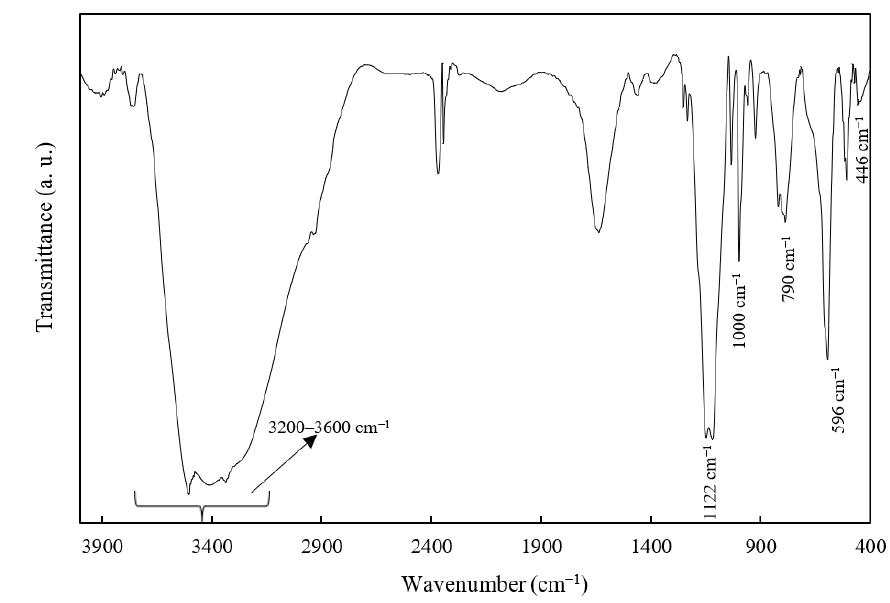
Figure 2. The FTIR spectrum of the as-synthesized ZHS nanoplates. The survey and high ‐ resolution XPS spectra of the ZHS nanoplates were recorded (Figure 3). The presence of XPS peaks related to the zinc, Sulphur, and oxygen elements in the survey scan indicates the successful synthesis of the ZHS nanoplates [32]. The high ‐ resolution Zn 2p XPS spectrum contains two peaks at 1045.4 and 1022.4 eV for Zn 2p1/2 and Zn 2p3/2, respectively. Two spin energy levels are separated by about 23 eV, which is typical for Zn (II) species. The S2p high ‐ resolution spectrum was deconvoluted in dou ‐ blets at 167.8 and 168.7 eV for S2p 1/2 and S2p 3/2 , respectively, which can be attributed to